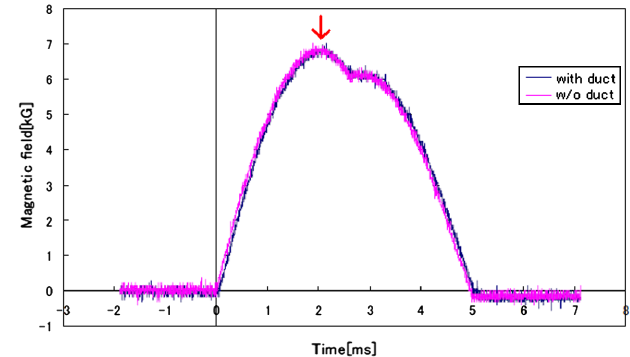
FIG. 23. Septum magnet and new vacuum ducts. The left duct is for the circulating beam and the right duct is for the extracted beam.